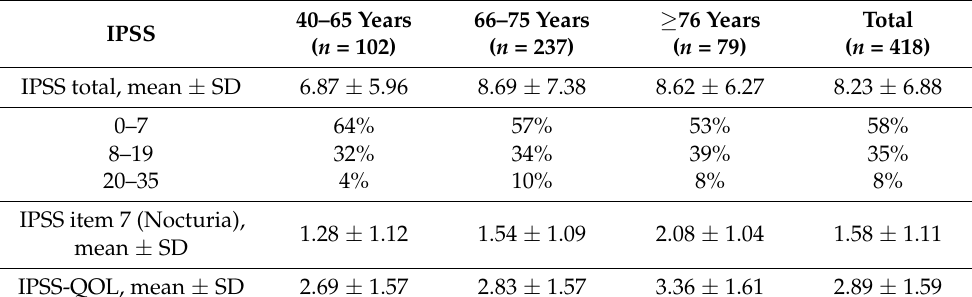
Table 2. IPSS according to age groups.